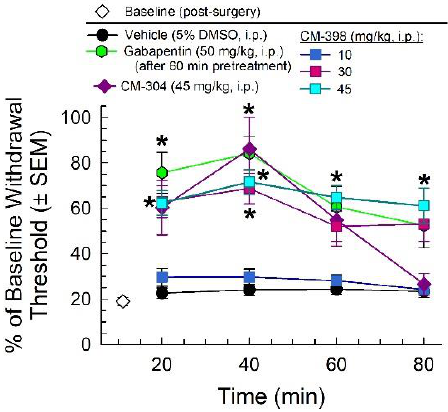
Figure 5. Dose- and time-dependent anti-allodynic activity of CM-398 (squares) in the mouse chronic constriction injury (CCI) model of neuropathic pain. Mechanical allodynia produced from sciatic nerve ligation was reduced from 40 – 80 min post-CM-398 (30 mg/kg, i.p., pink squares, and 45 mg/kg, i.p., cyan squares) in a manner similar to the positive control, gabapentin (50 mg/kg, i.p., green hexagons). CM-398 produced effects that were longer lasting than the parent compound CM-304 (45 mg/kg, i.p., dark-purple diamonds). N = 10 for all groups; * = significantly different from vehicle controls; p < 0.05; two-way ANOVA with Tukey post hoc test. (Note: CM-304 data were previously published in Cirino et al., 2019 [9]).